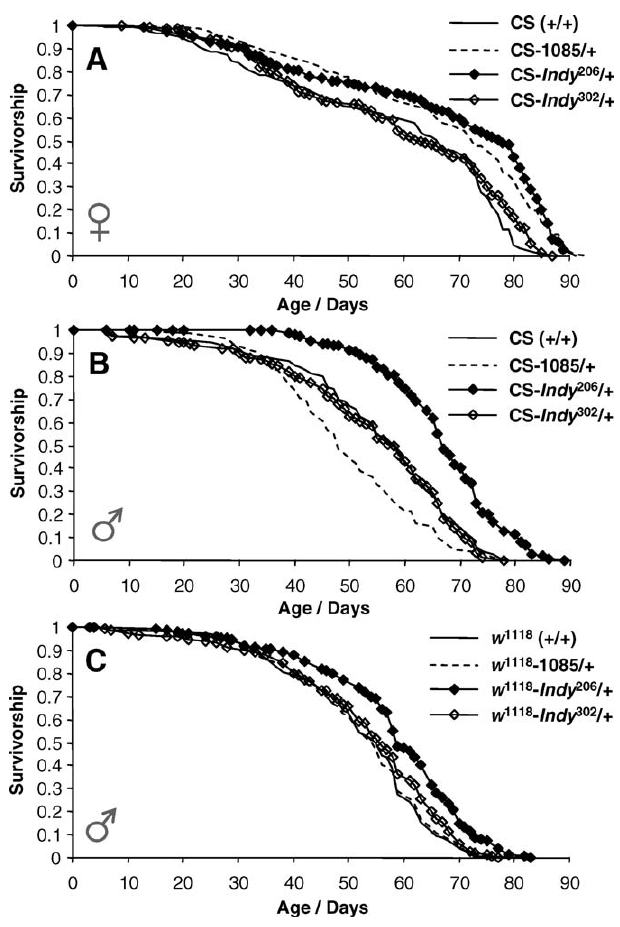
Figure 2. Association of Indy 206 Line with Longevity Is Diminished by Moderate